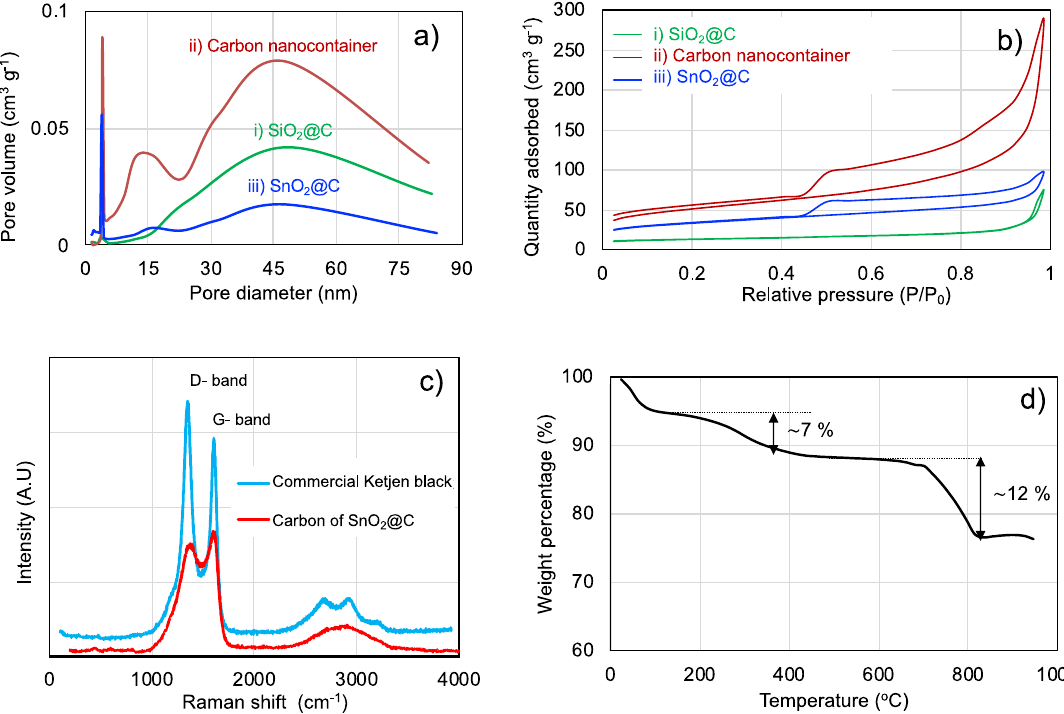
Figure 6. Pore distribution ( a ) and adsorption isotherms ( b ) of (i) SiO 2 @C before silica removal, (ii) hollow carbon nanocontainers after silica removal and (iii) SnO 2 @C nano-rattles after melt di ff usion. Raman spectrum analysis of carbon structure ( c ) and TGA ( d ) of SnO 2 @C.